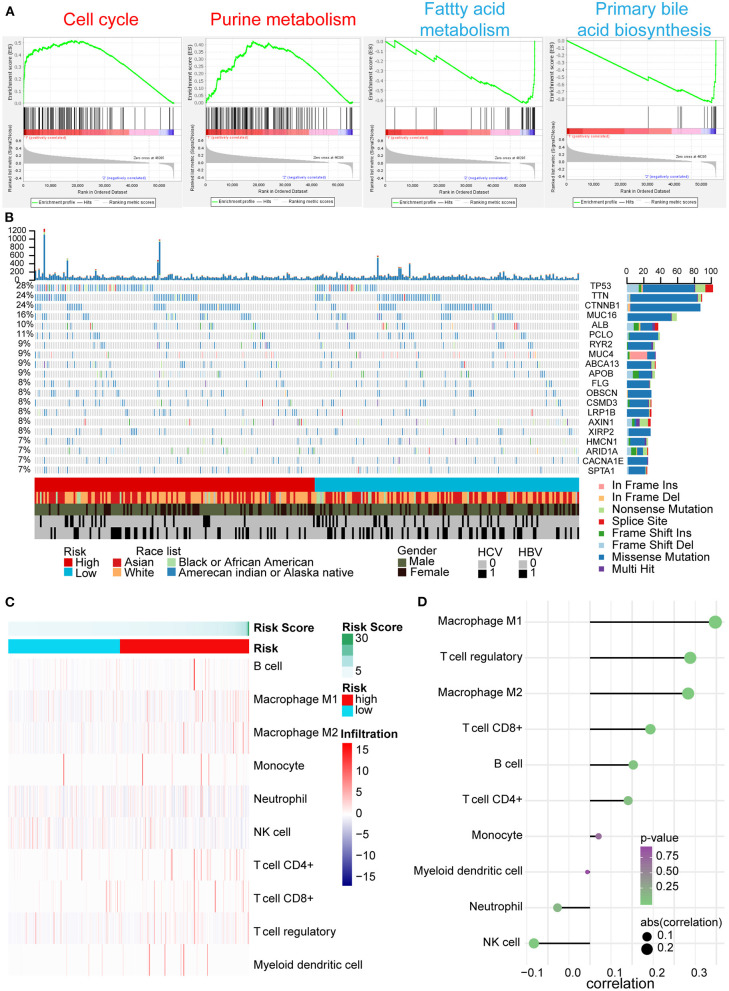
GSEA, gene mutation analysis, and immune infiltration of the high- and low-risk groups based on the five-AR-lncRNA signature. (A) GSEA of the differentially expressed genes between the high-risk group (marked in red) vs. low-risk group (marked in blue). For each group, only two most significantly enriched functional gene sets are shown. (B) The genomic landscape and mutational signatures of 307 HCC patients (84.34% of 364 samples). Individual tumor mutation rates are shown in the top panel, whereas the risk, race, gender, and HCV and HBV infection status of HCC patients are detailed in turn in the bottom panel. The middle panel shows genes with statistically significant levels of mutation (MutSig suite, FDR <0.1). The name and type composition of each mutant gene are shown on the right, and mutation types are indicated in the legend at the bottom, respectively. (C) Association between risk score and immune cell population in low- and high- risk groups. (D) The bubble map shows the correlation between risk score and immune cell subset infiltration. X and Y axes represent the correlation coefficient and the type of infiltrated immune cell subset, respectively. The color of each bubble shows the p-value of correlation, whereas the size shows the absolute value of correlation coefficient.